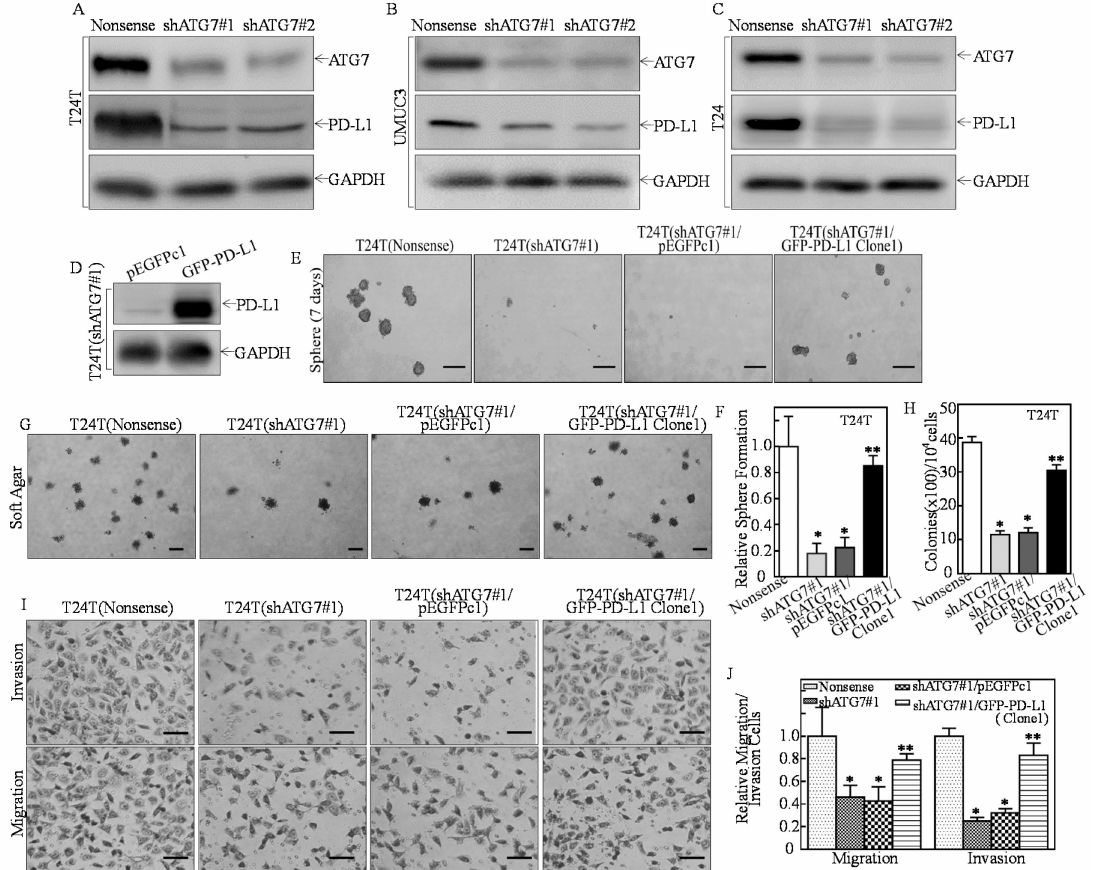
Figure 1. PD-L1 acted as an ATG7 downstream mediator being responsible for ATG7-promoted stem-like property, invasion, and anchorage-independent growth in human high invasive BC cells. ( A – C ) T24T, UMUC3, T24 cells were stably transfected with ATG7 knockdown constructs (#1 & #2), respectively. Western Blot was used to assess the ATG7 protein knockdown efficiency and its effects